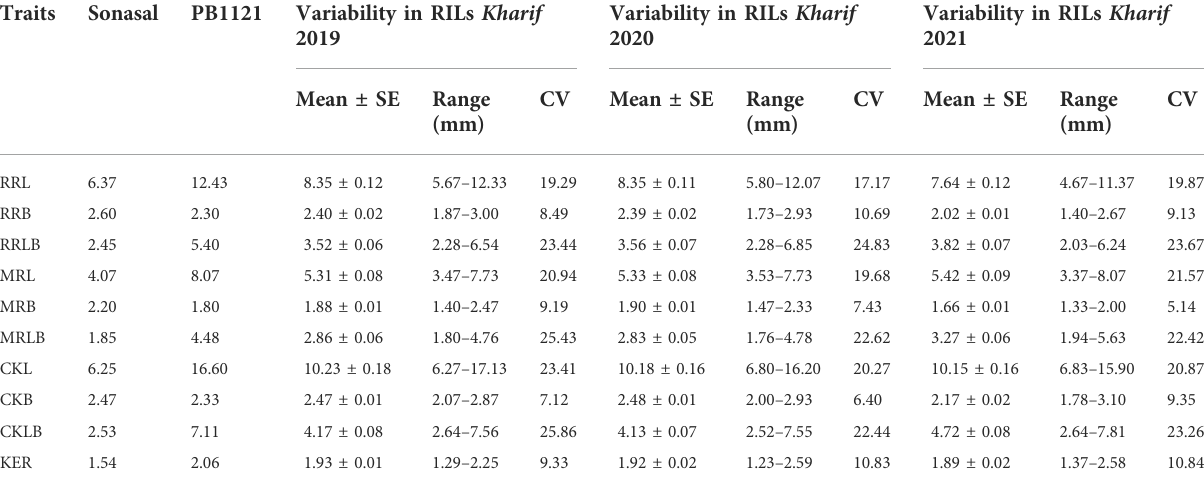
TABLE 1 Descriptive statistics of Sonasal, PB1121, and RIL